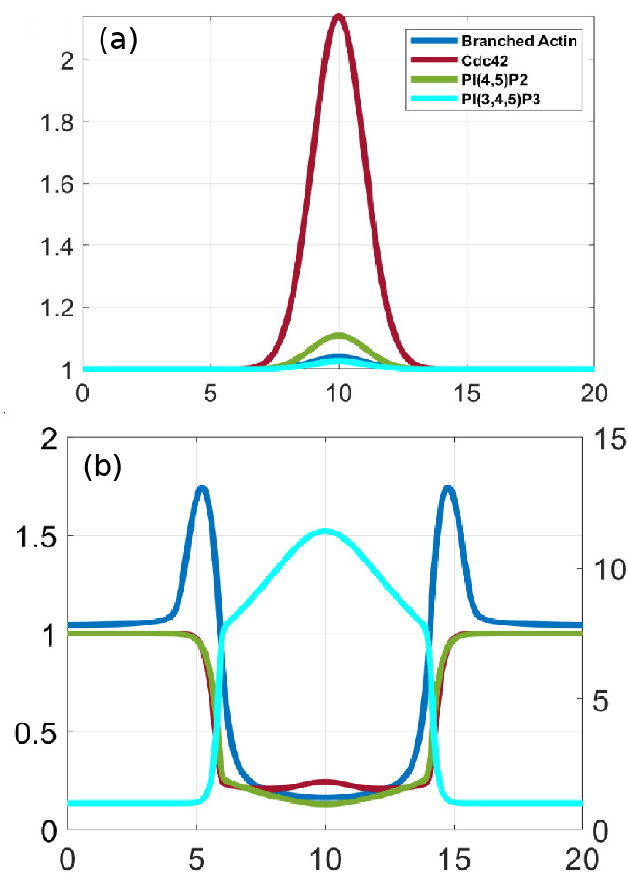
Figure 14. Branched actin wave initialization and propagation. Shown are the profiles of branched actin, PI(4,5)P2, Cdc42, and PIP3 at t = 5 s ( a ), and 180 s ( b ) after a perturbation. The concentrations are normalized by the original steady state. The right axis on ( b ) is for PI(3,4)P2, which is shown in light